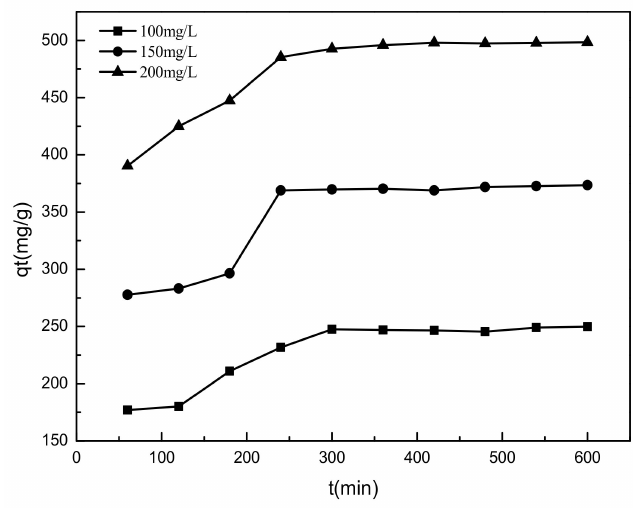
Figure 9. Effect of adsorption time on adsorption